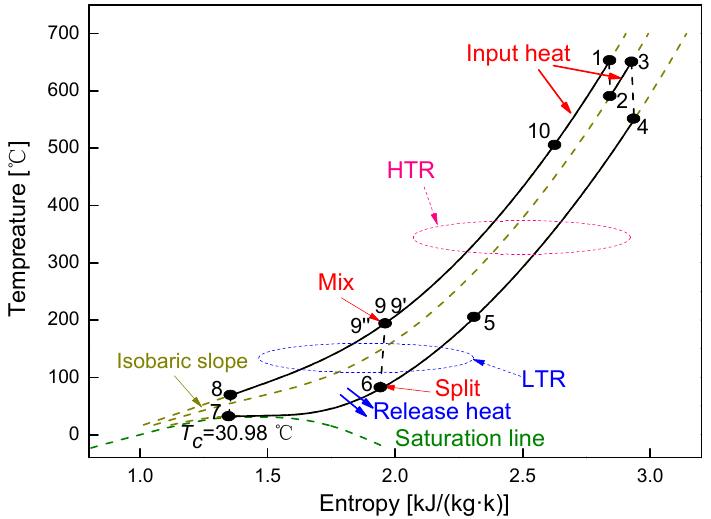
Figure 2. Temperature-entropy diagram of S-CO 2 recompression cycle with reheater.